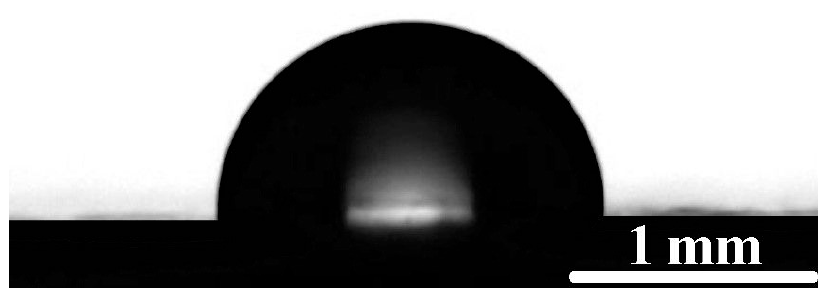
Figure 1. Wettability of pristine Polyvinylchloride (PVC) catheter is illustrated. The apparent contact angle is close to π . 2